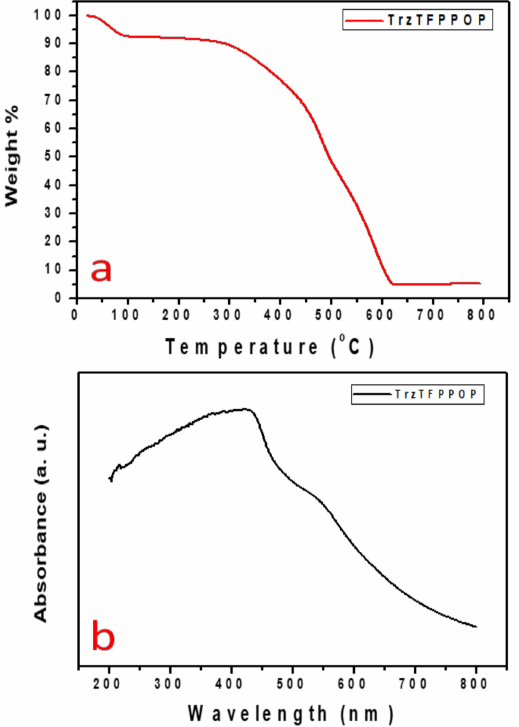
Figure 3. TGA profile diagram ( a ) and solid-state UV–Vis spectrum of TrzTFPPOP ( b